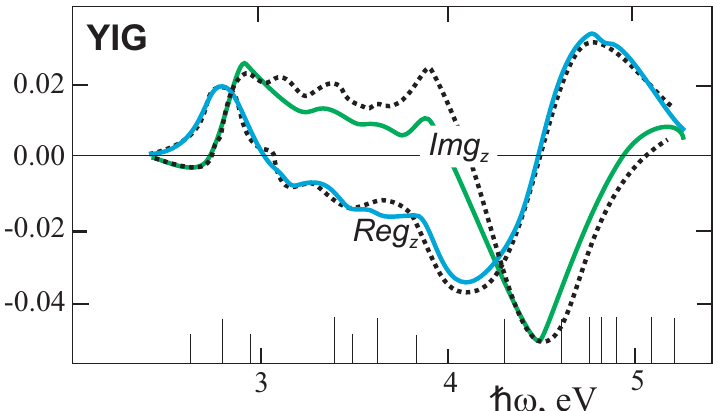
Figure 5. Spectral dependence of the real and imaginary parts of the z -component of the gyration vector in YIG: experimental data are shown by dotted curves; model fitting is shown by solid curves. Adapted from [32].